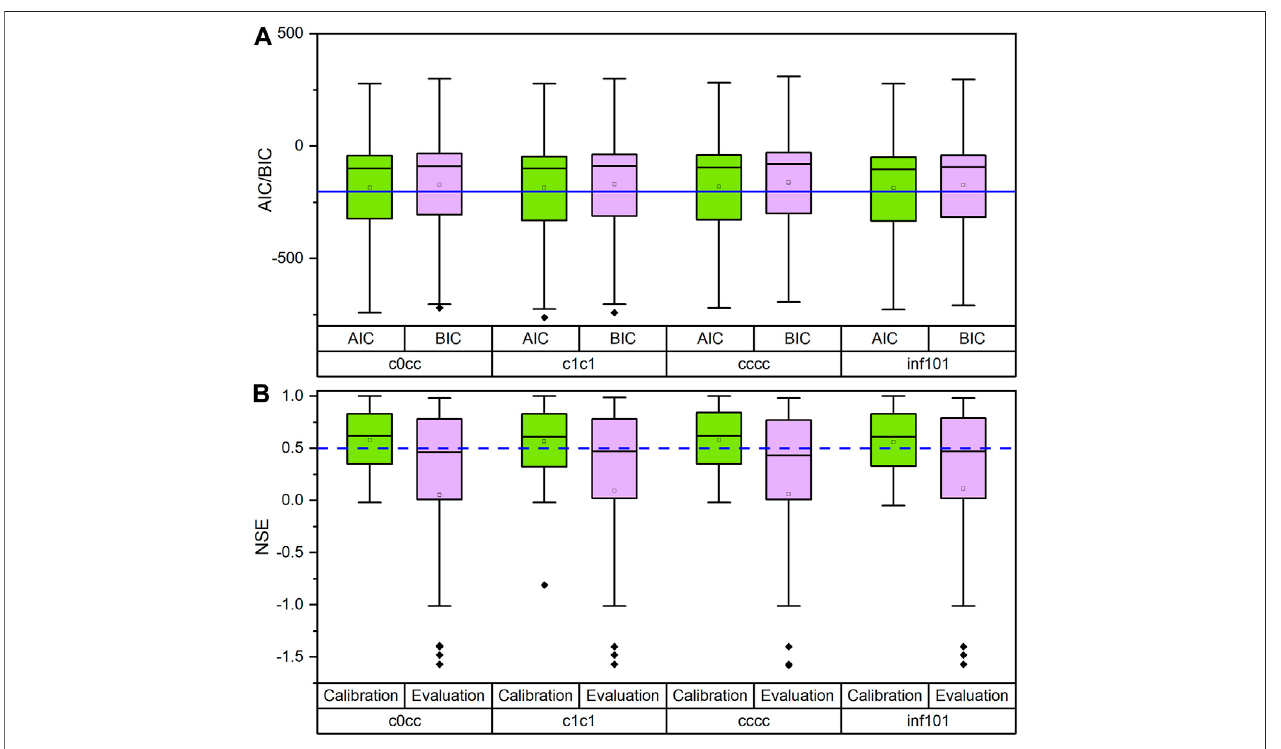
FIGURE4| BoxplotofAICc,BIC (A) andNSE (B) resultsofthefoursoilmodelstructuresintheclimate-onlyanalysis.Note:Structureccccmeansallparametersof k sat , α , β , and γ are calibrated. Structure c1c1 means α (cid:2) γ (cid:2) 1. Structure c0cc means α (cid:2) 1. Structure inf101 means α (cid:2) γ (cid:2) 1 and β (cid:2) 0.